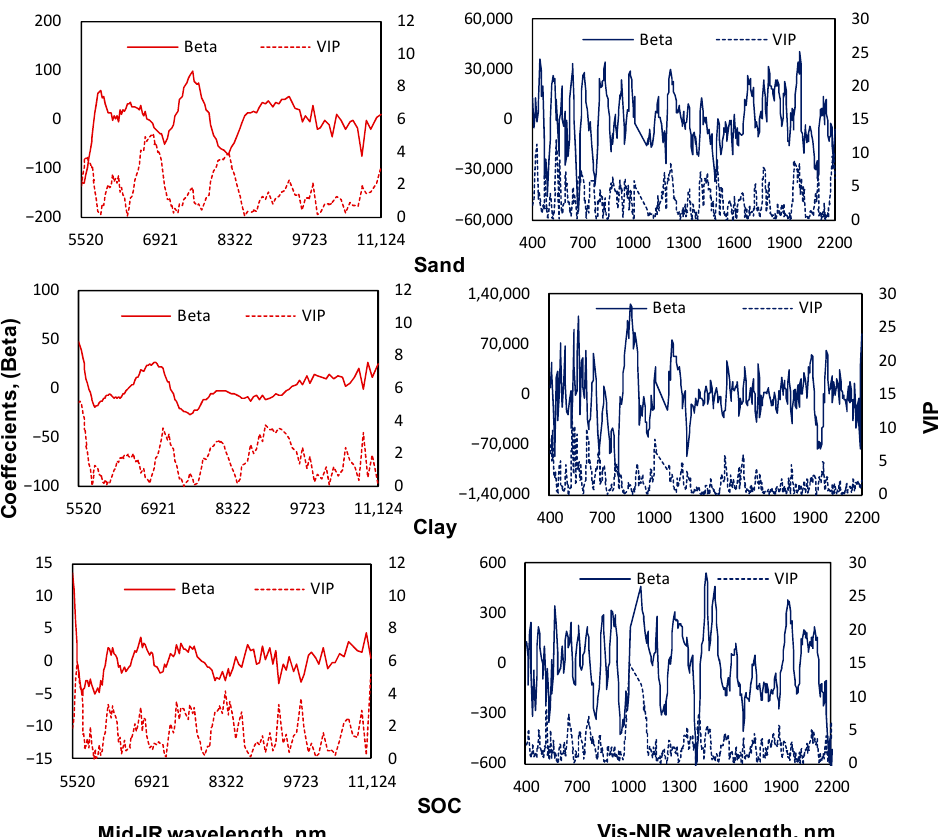
Figure 11. Relationships between measured and predicted SOC, with dots representing validation examples in accordance with Tables 3 and 4.